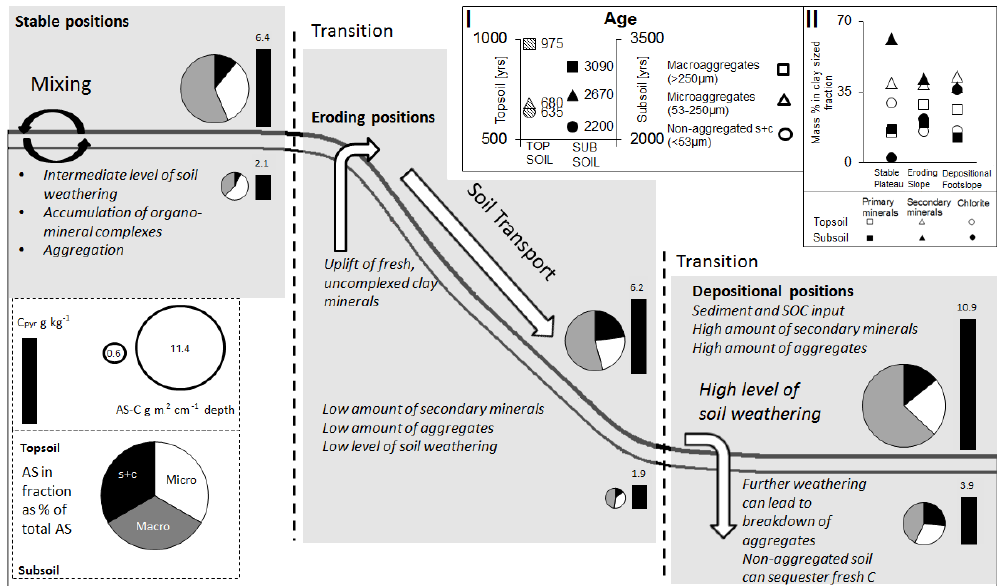
Figure 6. Conceptual figure showing the mineralogical changes along the slope in relation to the abundance of AS in non-aggregated silt and clay (s + c), microaggregates, and macroaggregates. Statement on the level of soil weathering along the transect refers to both topsoil and subsoil. Pie charts show the relative contribution of AS in each fraction to total AS by multiplying ASgC − 1 in a fraction with C stock estimates of the respective fraction given in Table 1. The size of the pie chart indicates the absolute AS content of these fractions combined in gm − 2 and per cm depth of a profile. The amount of C extracted with pyrophosphate in the bulk soil is given as a column next to each AS pie chart. Panels at the top right show the distribution of primary and secondary minerals along the slope in different depths (I) (see also Table 4) and the relative 14 C derived ages of these fractions in topsoil and subsoil for the depositional site (II), indicating differences between the fractions (see also Table